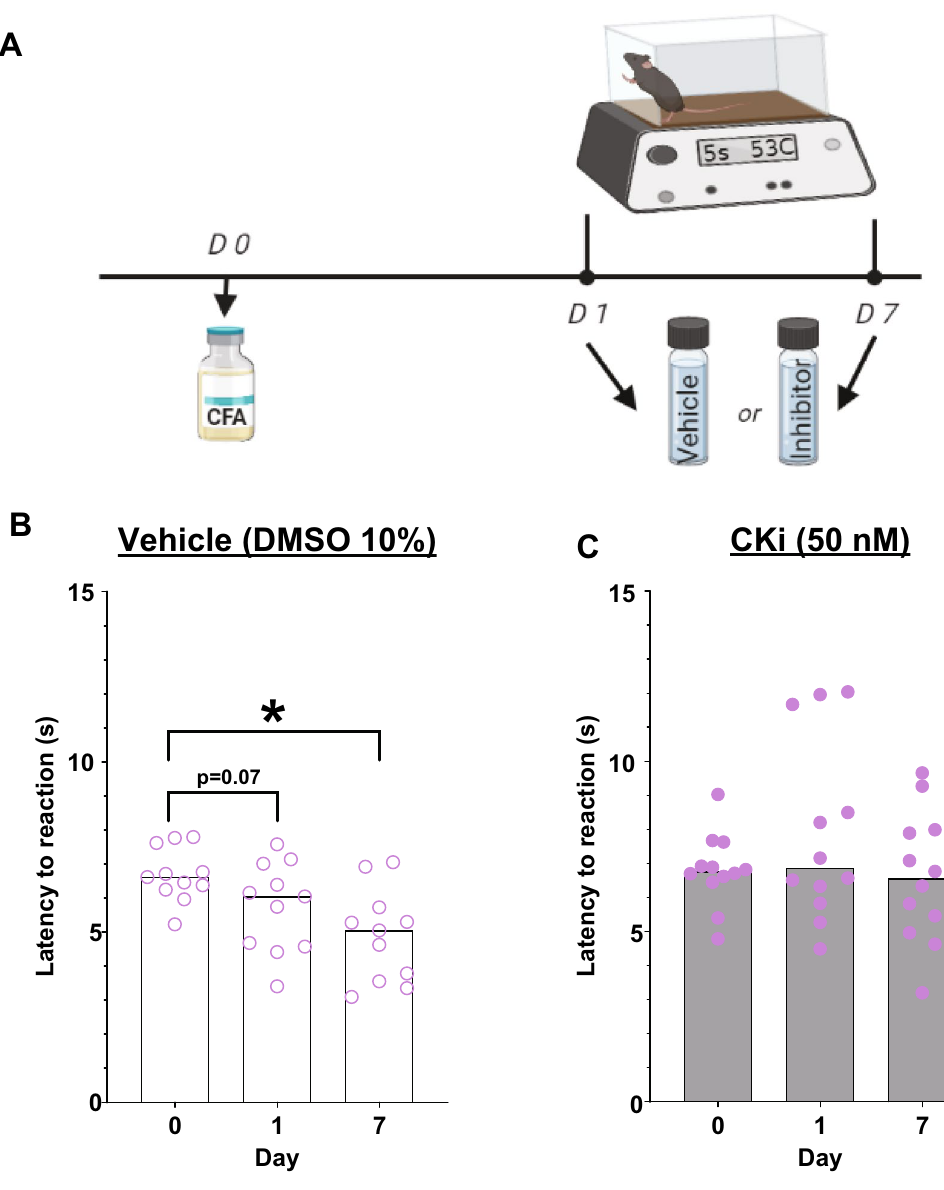
Figure 4. Cathepsin K inhibitor (50 nM) reduces thermal hypersensitivity in mice. ( A ) Timeline for testing thermal hypersensitivity. ( B ) Vehicle-injected mice have a significantly lower thermal latency than day 0 (baseline) on day 7 post-CFA injection. ( C ) 50 nM cKi-injected mice show no significant change in thermal latency than day 0 (baseline) post-CFA injection. Data are represented at scatter plots of individual mice with bar graphs overlayed indicating the median value. *p < 0.05 Mann–Whitney test between time points for each